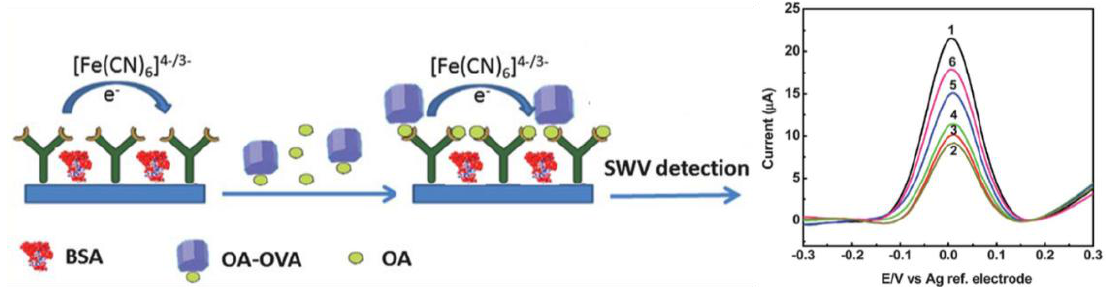
Figure 3. Schematic display of the working principle of the immunosensor based on a direct competitive format and SWVs of the immunosensor before the competition step (1) and after incubation with different concentrations of OA: 0.00 (2), 1.00 (3), 10.0 (4), 100 (5) and 1000 (6) ng L −1 . Reprinted and adapted from [59] with permission.